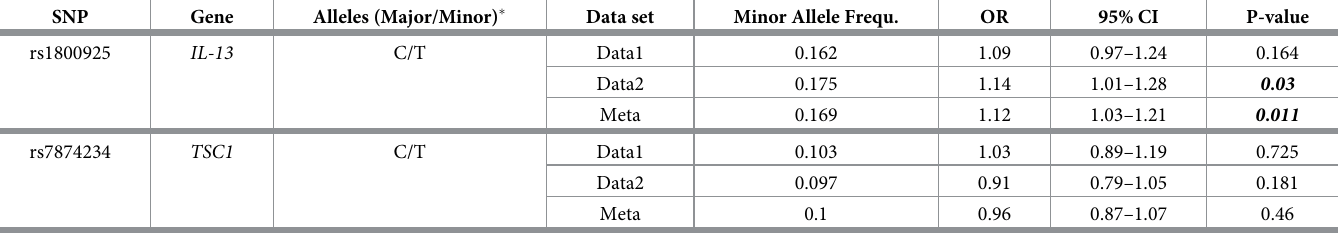
Table 4. Replication results in the Shanghai breast cancer genetics study. SNP Gene Alleles (Major/Minor) � Data set Minor Allele